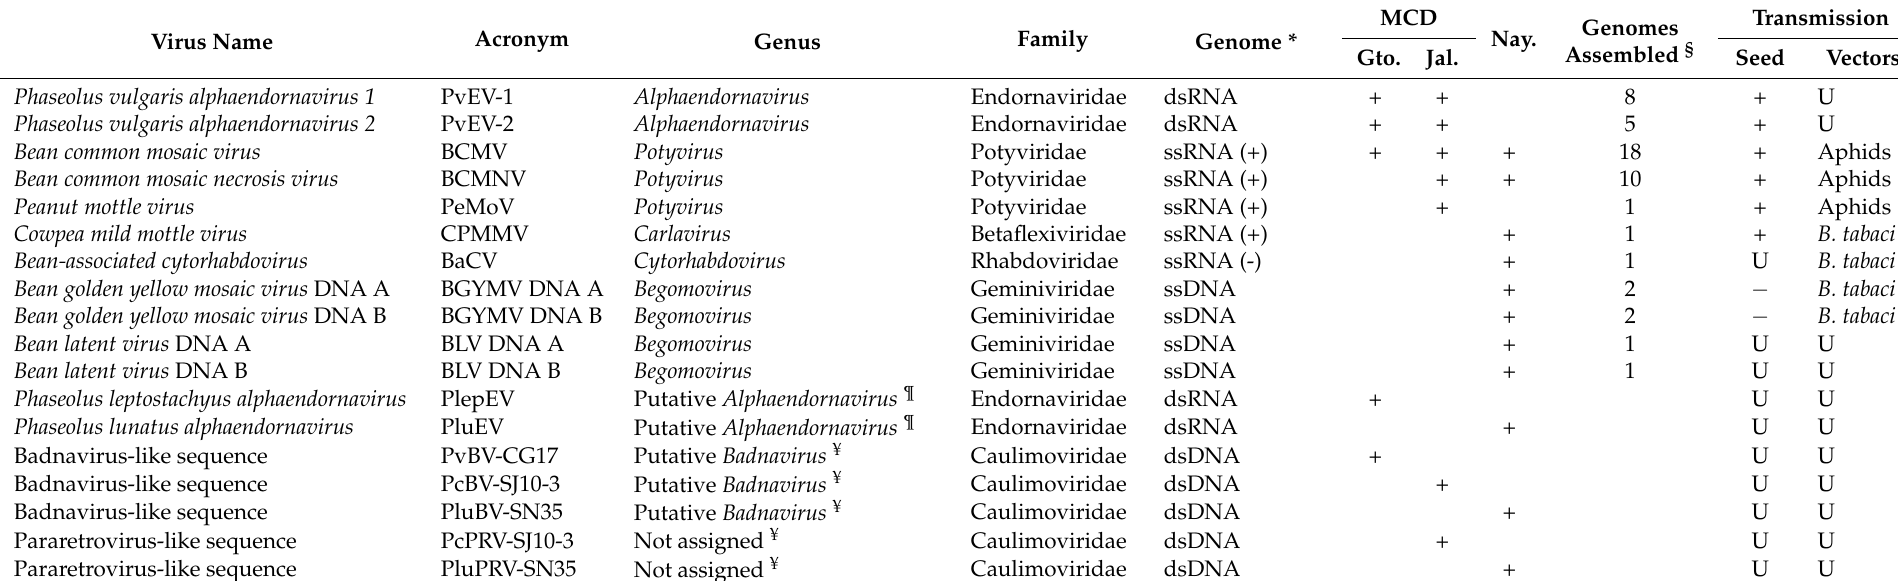
Table 1. Distribution, numbers of assembled genomes, and transmission of viruses infecting Phaseolus spp. in the MCD and Nayarit,